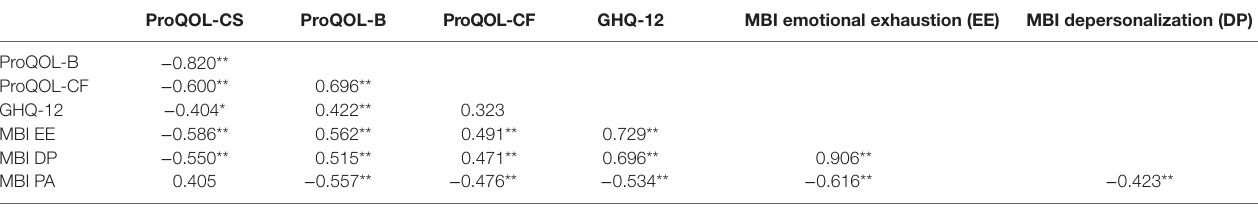
TaBle 3 | comparison between Maslach Burnout inventory (MBi), Professional Quality of life (ProQOl), and 12-item general health Questionnaire (ghQ-12)